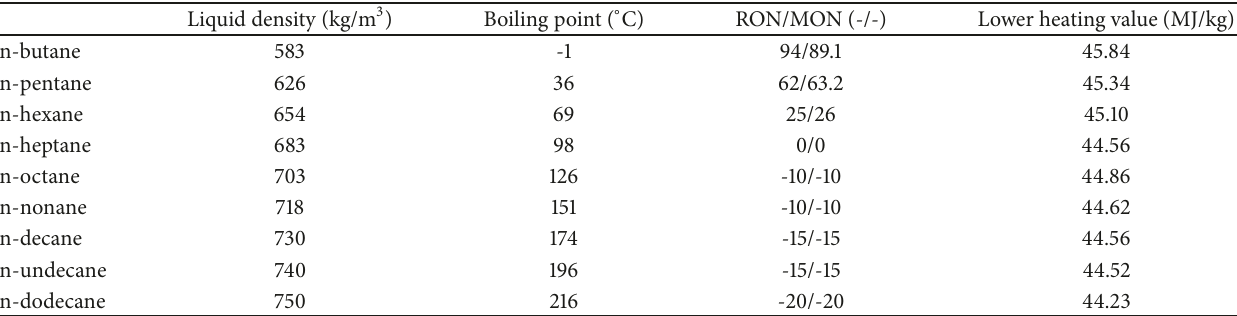
Figure 1: Simulated ignition delay times for the pure components in air at a pressure of 20 and 40 bar and equivalence ratio of Φ =0.5. Simulations were carried out using Samimi Abianehet al. [19] kinetic model in an adiabatic constant-volume model.Gasoline RD387 ignition delay experimental data were taken from Kukkadapu et al. [23] and Gauthier et al. [10] for comparison purpose. Table 3: n-Alkane group component